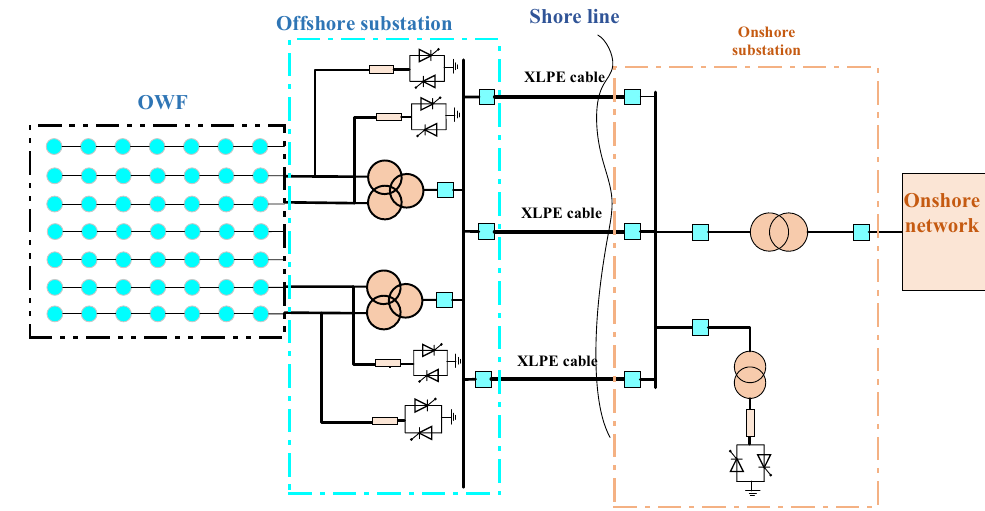
Fig. 4 Basic configuration of HVAC